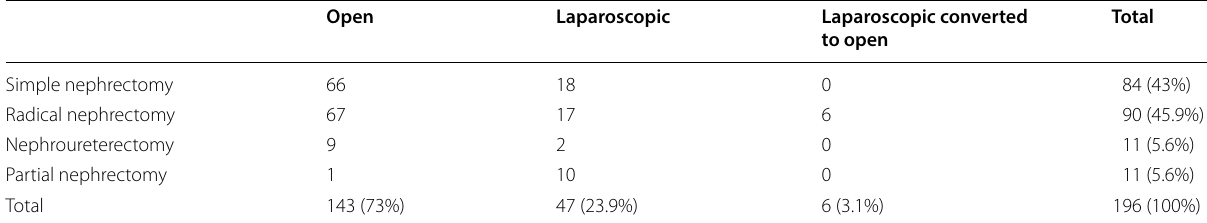
Table 2 Breakdown of surgical approaches